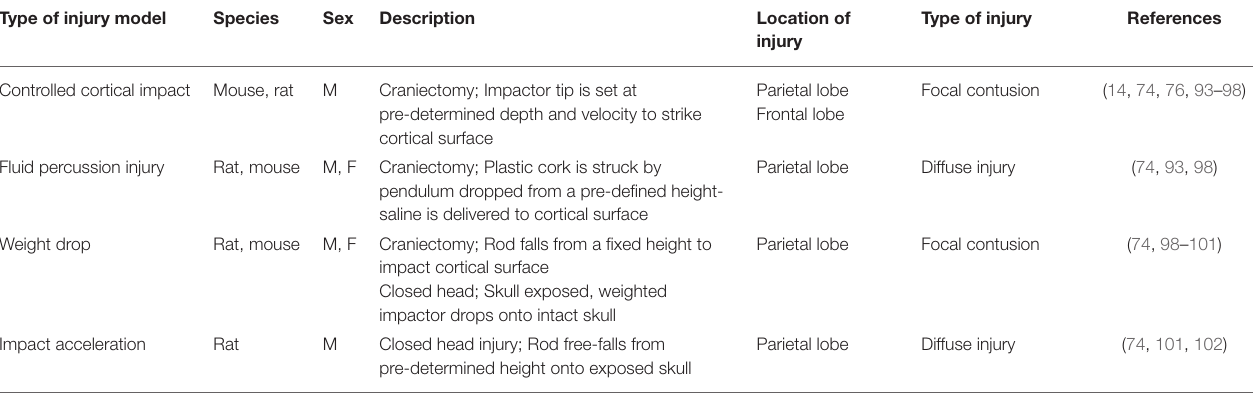
TABLE 1 | Pre-clinical models of traumatic injuries to the developing